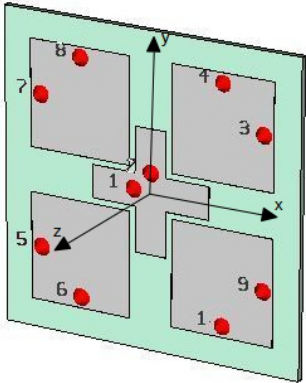
Figure 1. Antenna layout simulated by means of Computer Simulation Technology (CST) Microwave Studio.